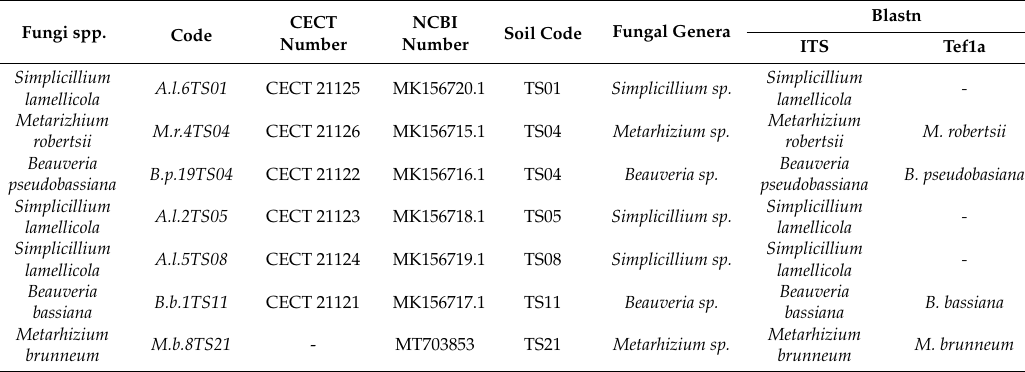
Table 1. Entomopathogenic fungi isolated from Tenerife Island banana crops soils. Fungi